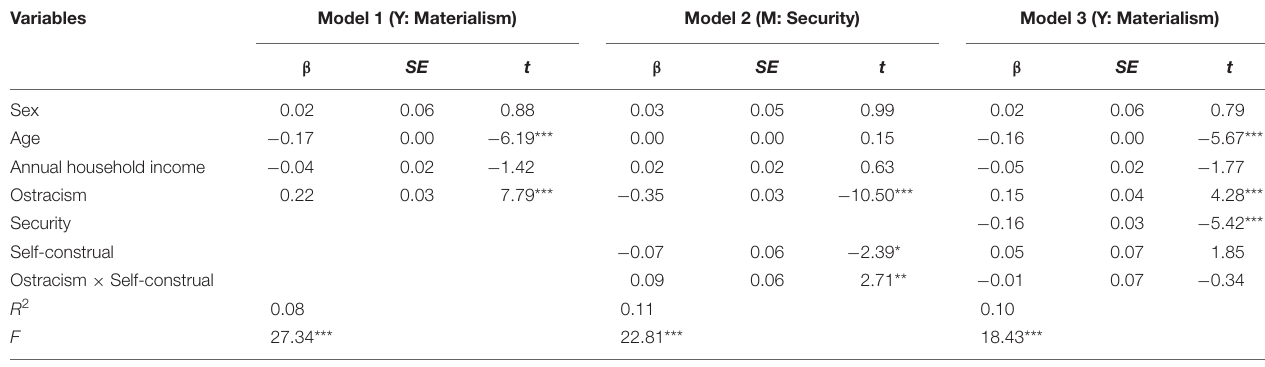
TABLE 2 | The moderated mediation model.